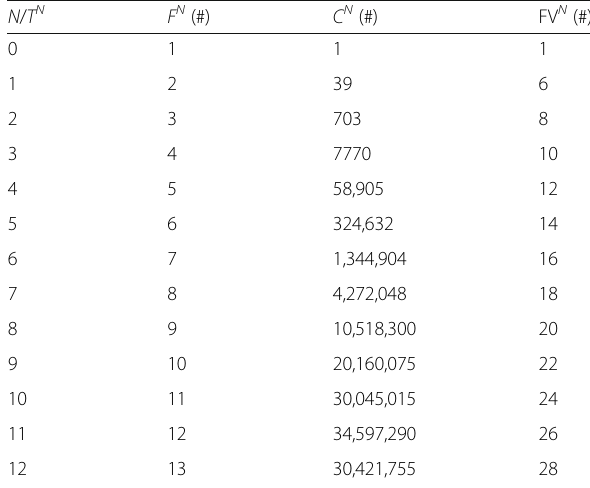
Table 3 Number of spectral thresholds and size of spectral threshold set ( N / T N ) and respective number of spectral sub-bands ( F N ), spectral threshold combinations ( C N ) and size of feature vector (FE N